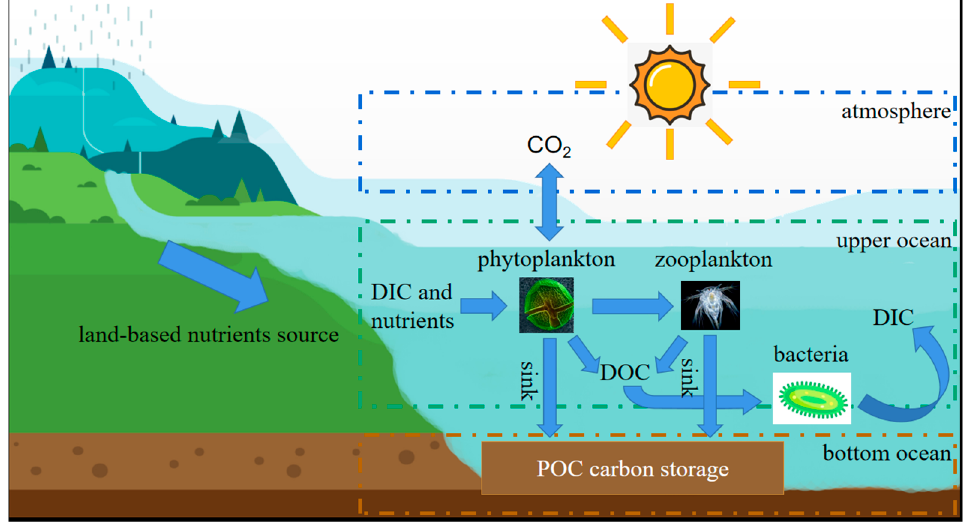
Figure 8. Nutrients and carbon interactions during spring algal bloom period.